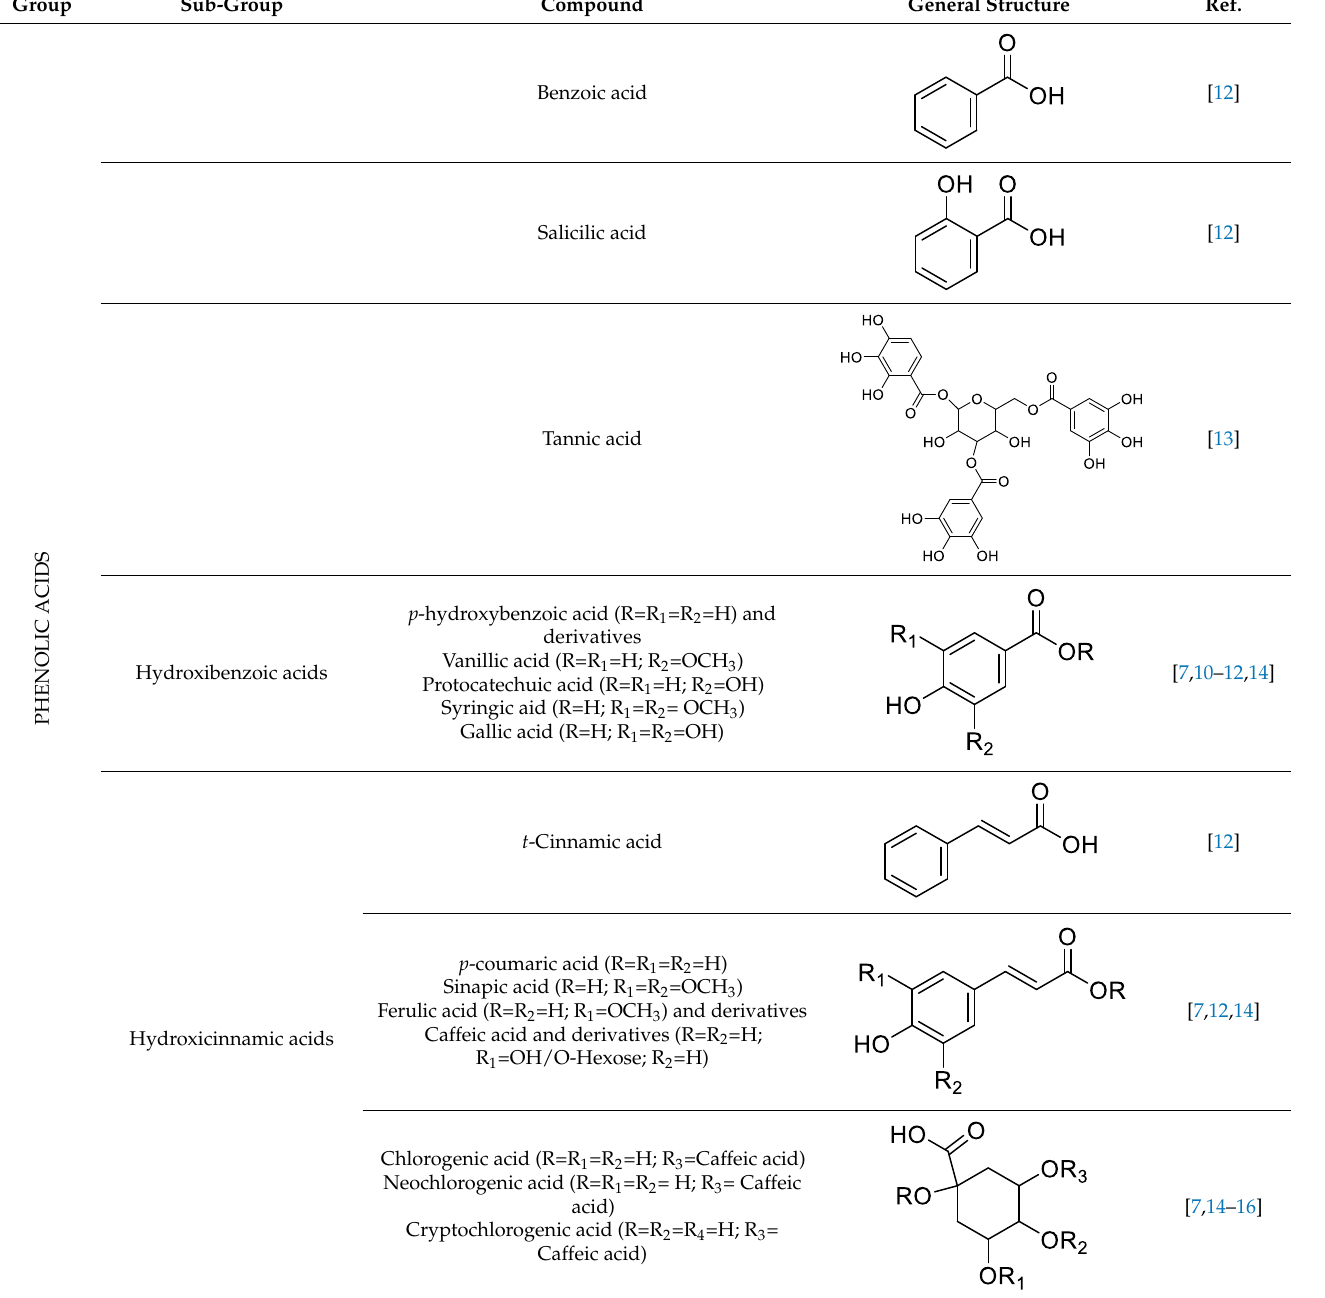
Table 1. Phenolic compounds identified in C. album Berries.